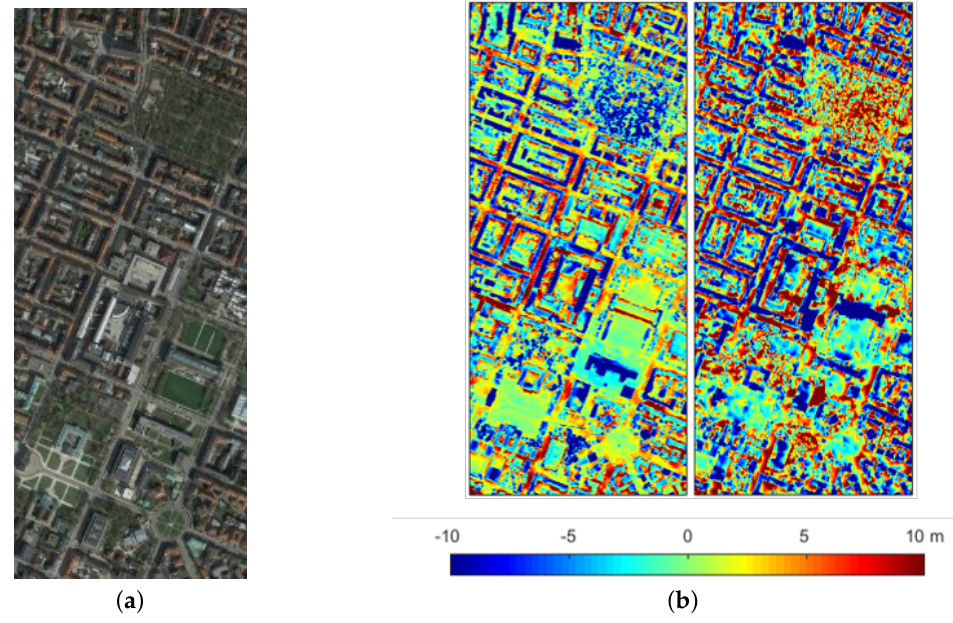
Figure 2. ( a ) Study subset selected over Munich, ( b ) Precision of the Cartosat-1 (left) and TanDEM-X (right) digital elevation models (DEMs) over an exemplary urban subset respective to high-resolution LiDAR data. Both DEMs were assessed with respect to a co-aligned LiDAR DEM.